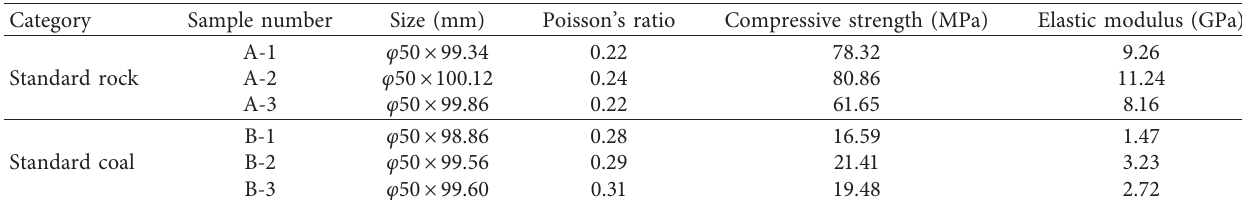
Figure 3: Stress-strain curve of single coal and rock Table 1: Physical and mechanical parameters of single coal and rock samples.